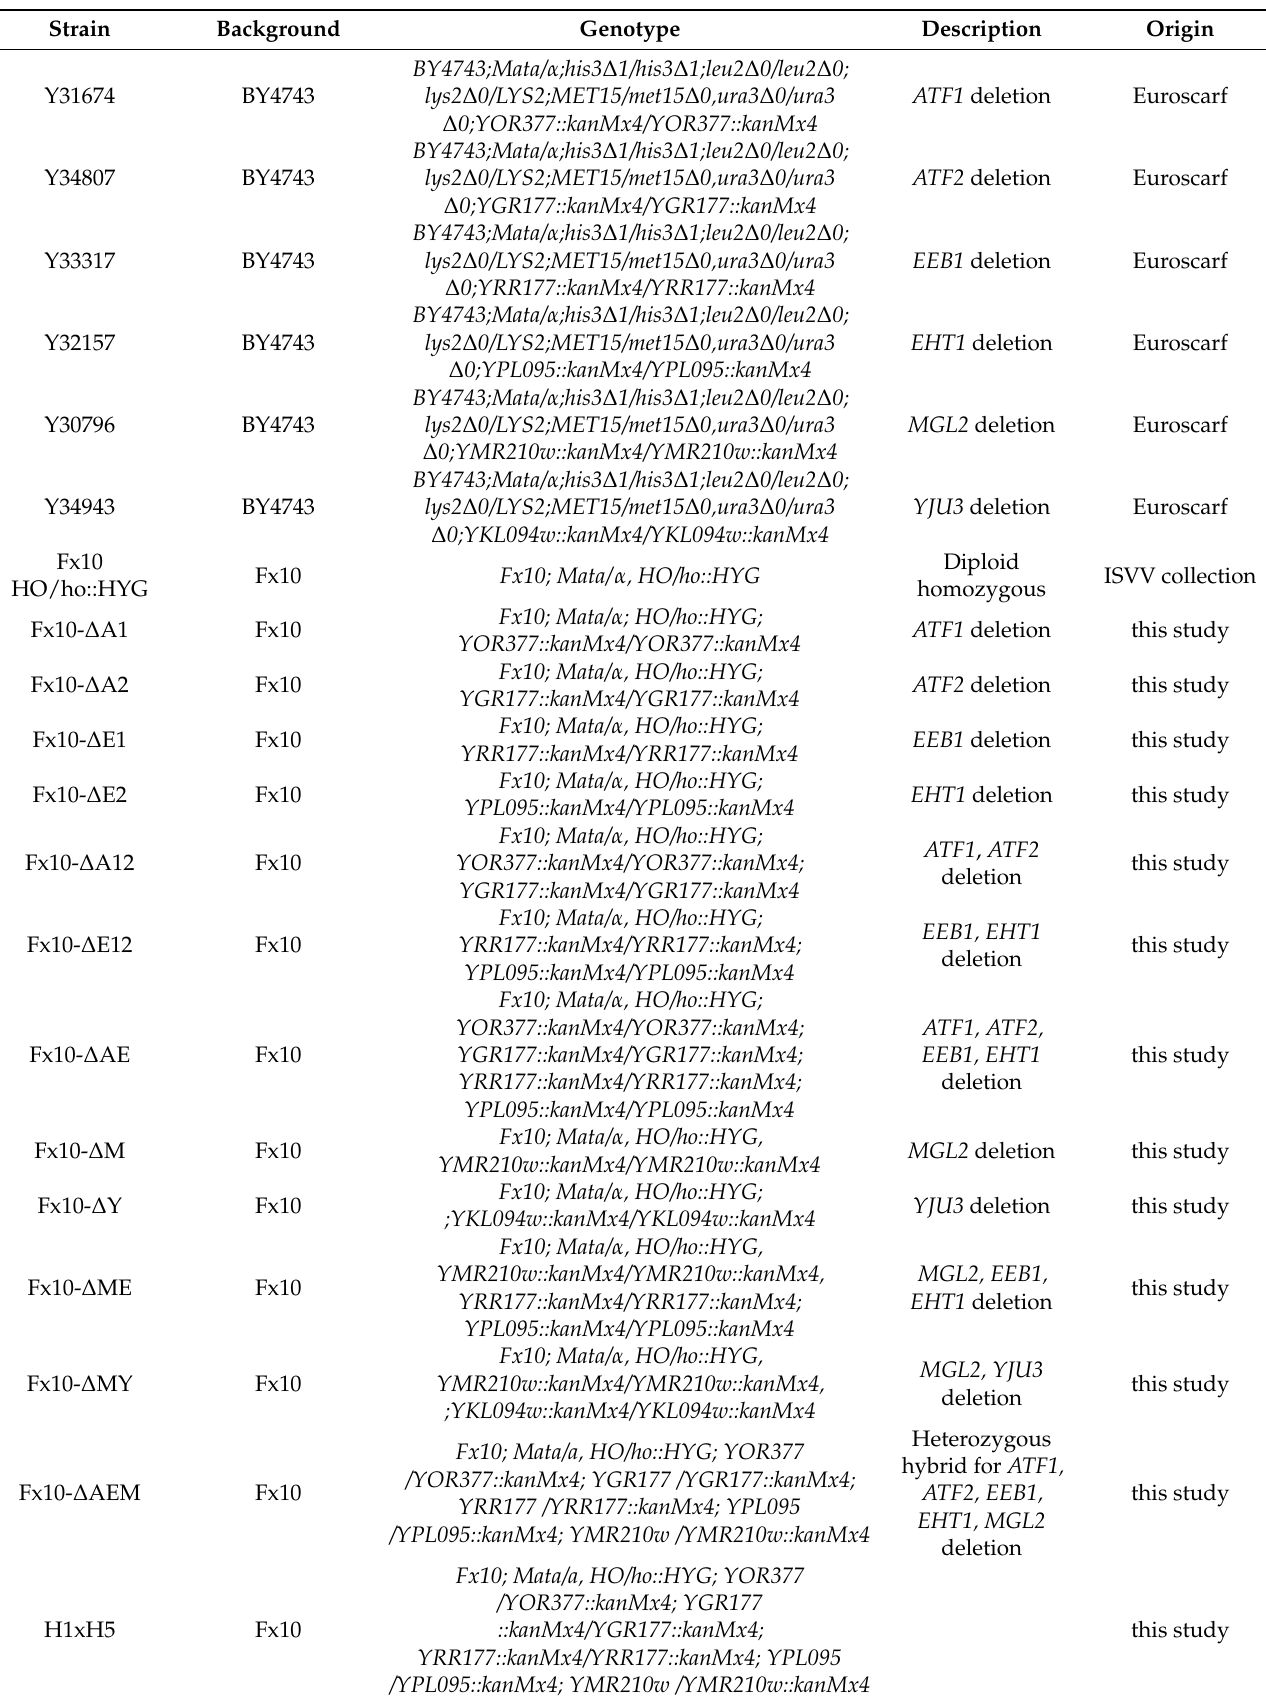
Table 2. Yeast strains